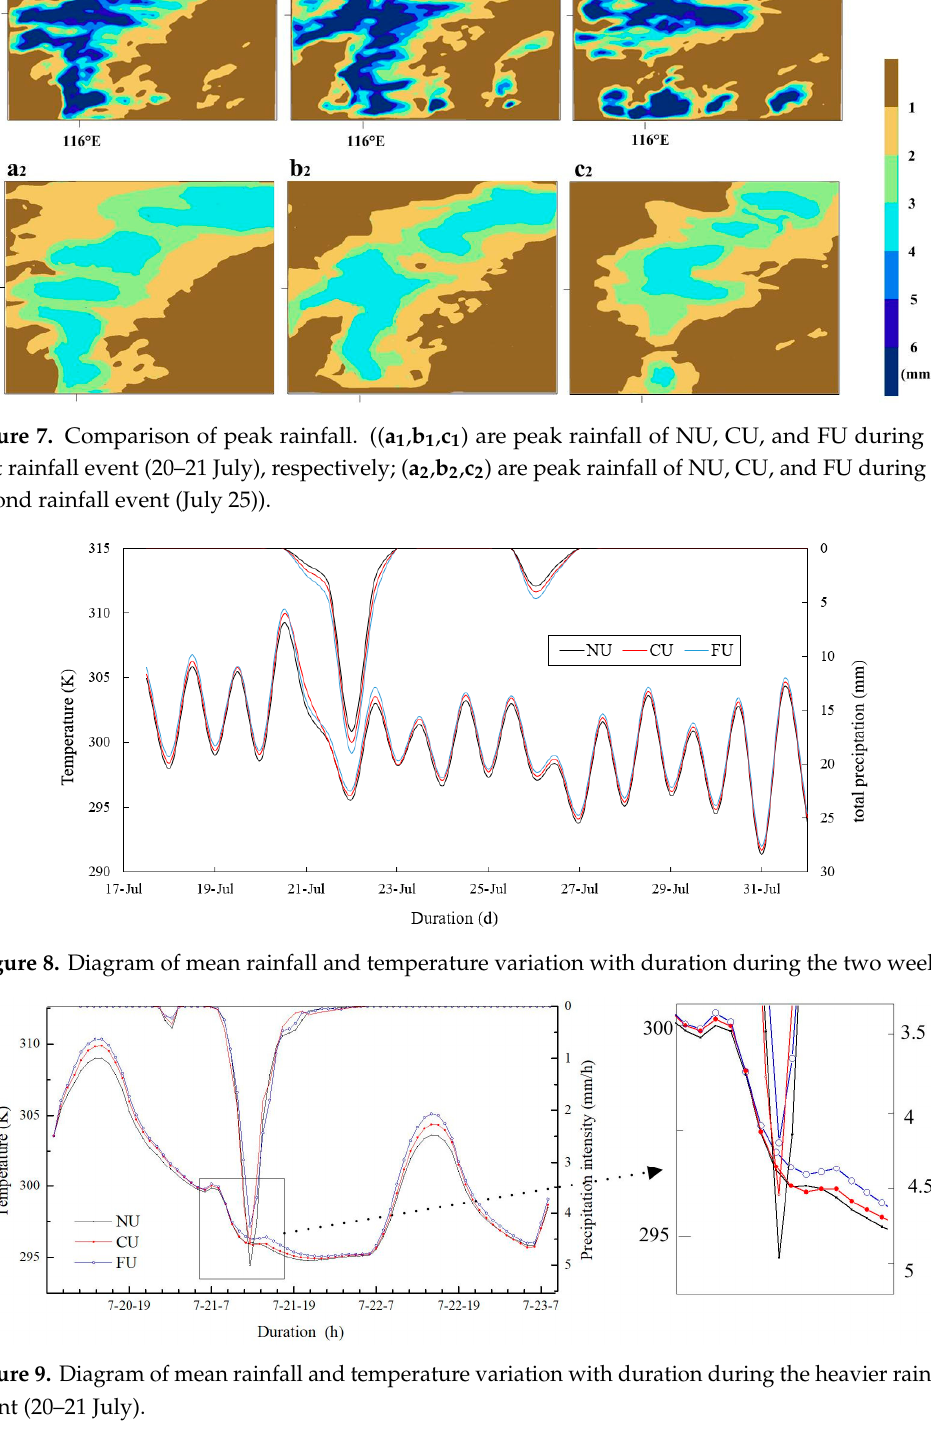
Figure 7. Comparison of peak rainfall. ( a 1 , b 1 , c 1 are peak rainfall of NU, CU, and FU during the first rainfall event (20–21 July), respectively; a 2 , b 2 , c 2 are peak rainfall of NU, CU, and FU during the second rainfall event (July 25)).